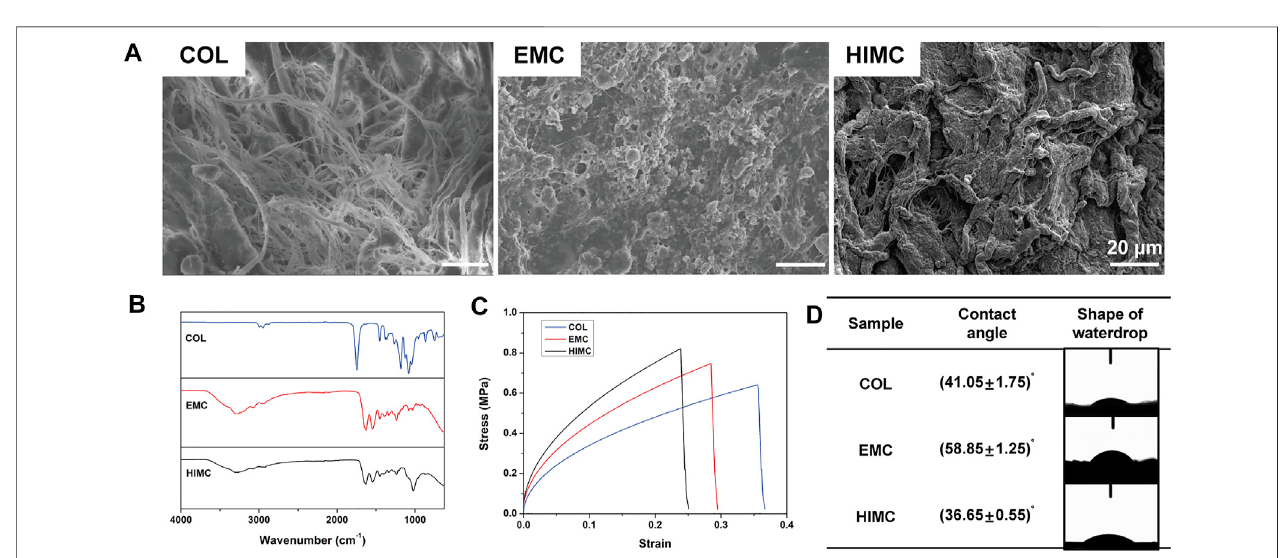
FIGURE 1 | Characterization of the different membranes. (A) Representative surface topography images visualized by SEM. (B) FTIR spectra. (C) Stress – strain curves. (D) Contact angle and representative waterdrop images. Scale bar, 20 μ m.